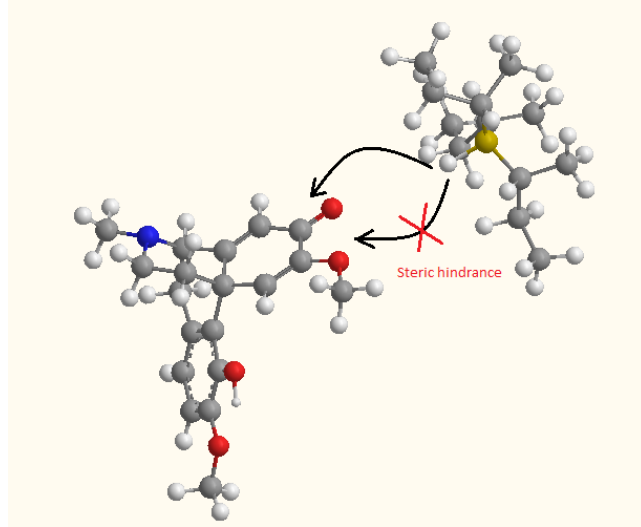
Figure 2. Presentation of the attack of tri-sec-butylborohydride ion to the DFT-optimized structure of compound 1 .